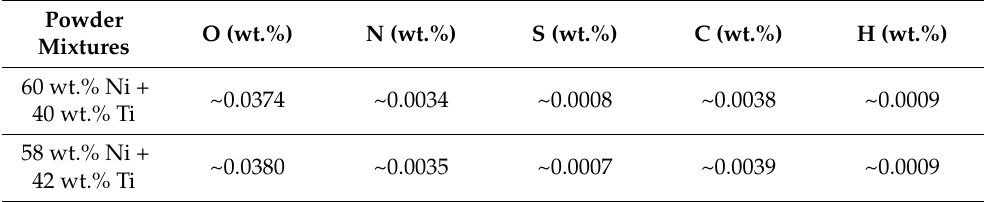
Table 2. Amounts of impurities existing in the powder mixtures having about 60 wt.% Ni + 40 wt.% Ti and 58 wt.% Ni + 42 wt.% Ti in their compositions.